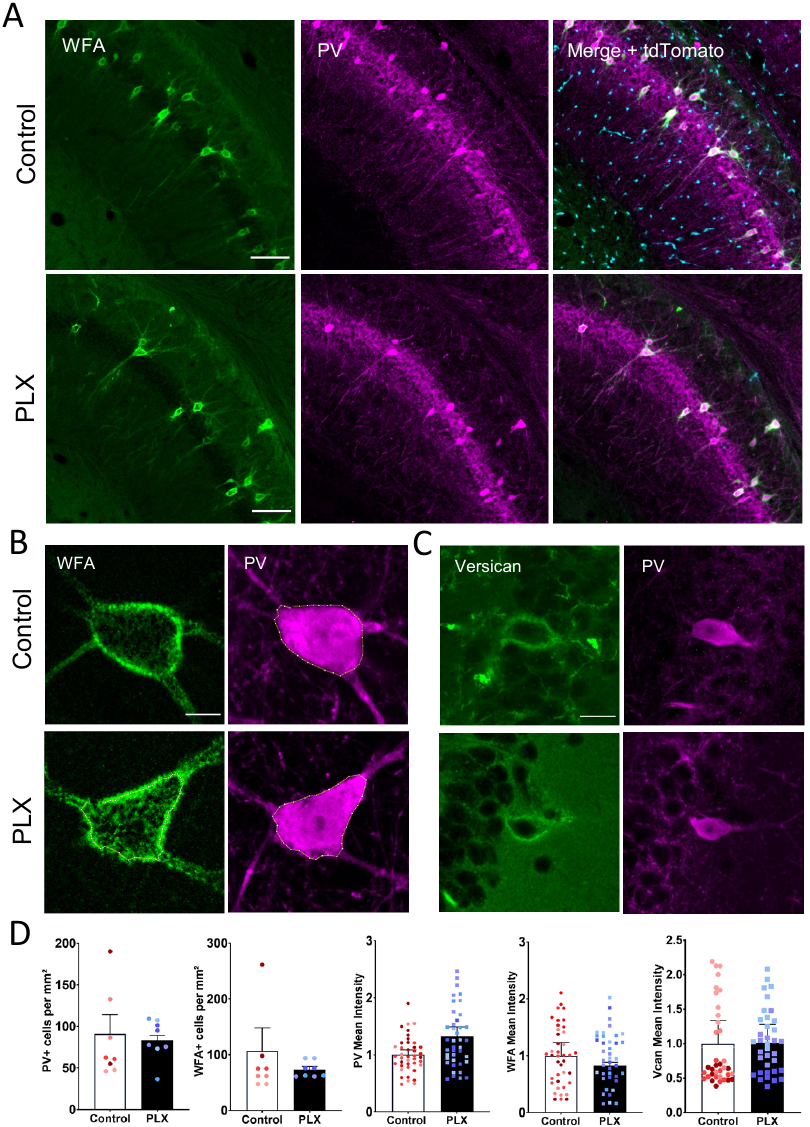
Figure 2. No detectable changes in the density of perineuronal nets after depletion of microglia. ( A ) Representative low (objective × 10) and high resolution ( B , objective × 63) confocal images showing tdTomato (cyan), WFA+ (green) and PV+ (magenta) cells in the hippocampus of 4-month-old Cx3Cr1-Cre mice. ( C ) Representative 63x images of control and PLX-treated hippocampi stained for PV and versican. ( D ) Bars show mean + SEM values per animal with superimposed individual values per cell. PLX treatment does not affect the number of PV+ or PNN+ cells. No changes in PV, WFA or Vcan mean intensities in PV+ cells could be detected (data from 4 mice in each group). Scale bars, 100 µ m ( A ), 10 µ m ( B ) and 20 µ m ( C